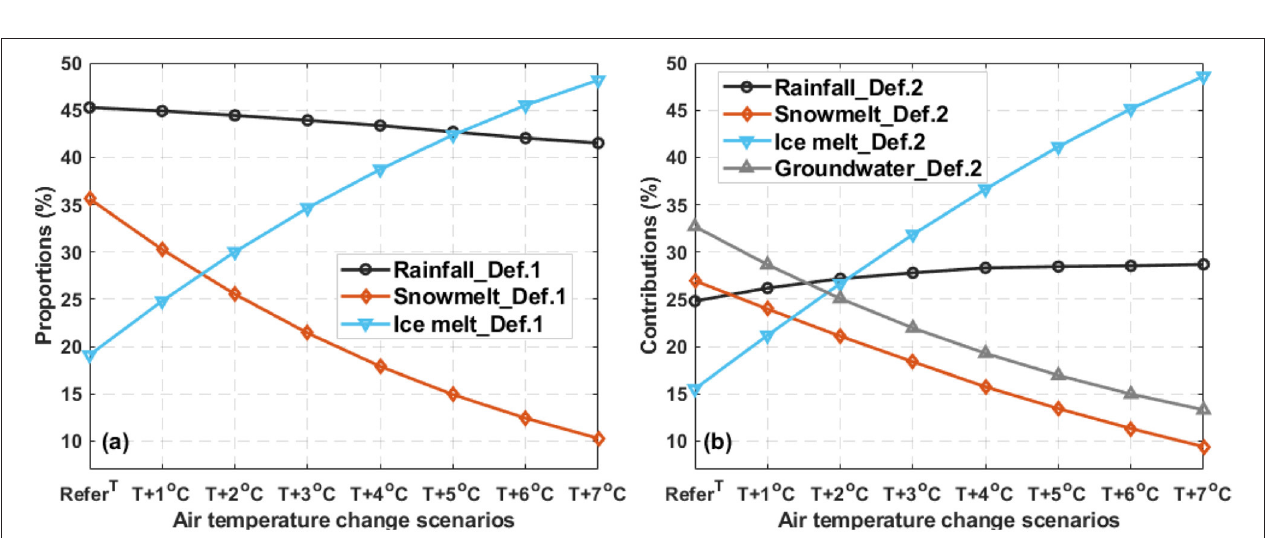
FIGURE 4 | Responses of monthly runoff and proportions of water inputs to the temperature warming. Boxplots indicate the inter-annual variabilities during the 20-year modeling period, and dots indicate mean values during the modeling period. (a) for the comparisons of monthly runoff simulations, (b–d) for proportions of rainfall, snowmelt and ice melt in the total water input.